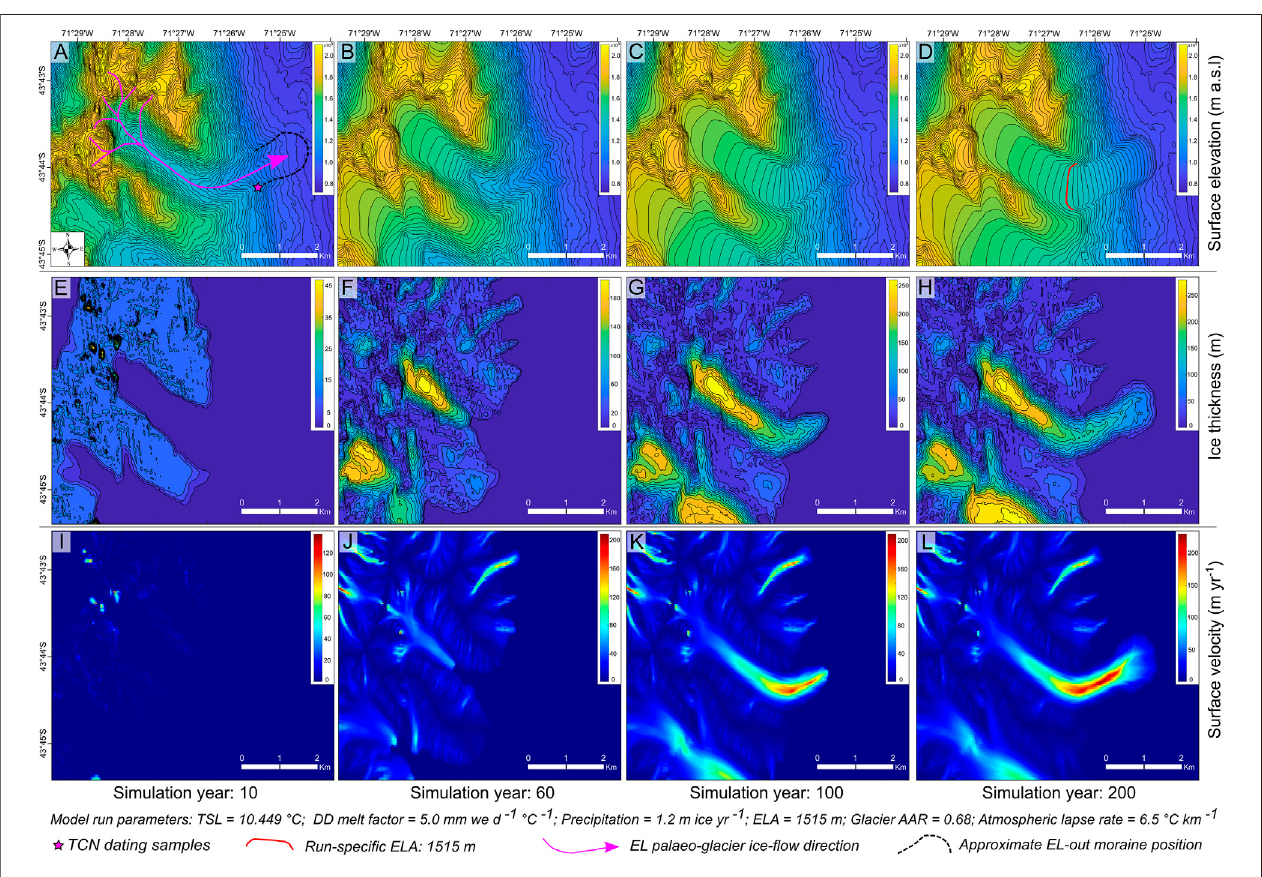
FIGURE6| Ice- fl owmodel output data( ∼ 30 × ∼ 30 mgrid-cellspatialresolution) foroneselectedmodel simulation oftheEL-outadvance. (A – D) Surfaceelevation data(ma.s.l.)includingAW3D30DEMdataplussimulatedicethickness, (E – H) icethicknessdata(m),and (I – L) ice-surfacevelocitydata(myr − 1 );forsimulationyears10 (panelsA,E,I),60(panelsB,F,J),100(panelsC,G,K)and200(steady-statevolume,panelsD,H,L).Notethatcolorbarvaluesandscalingarepanel-speci fi c.Equivalent fi gures speci fi c to the RCO-out and EL-mid advances/still-stands model simulations can be found in the Supplementary Figures S1,2 .